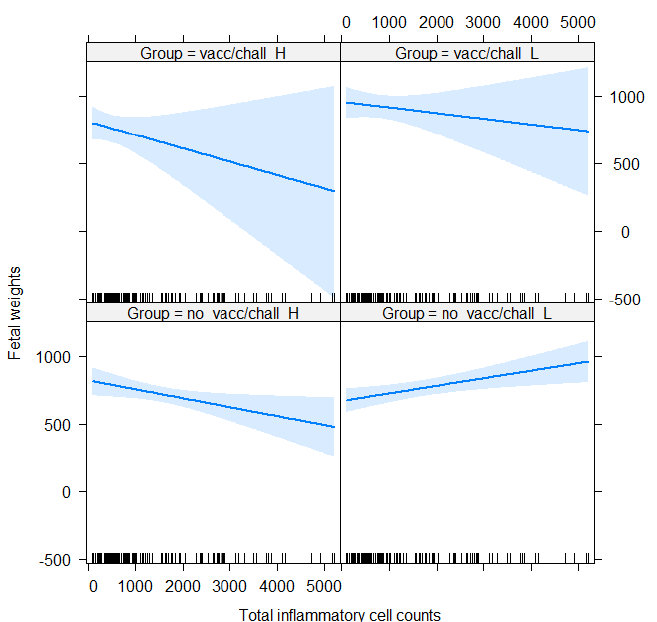
Figure 9. Correlations between fetal weights and total inflammatory cell counts. Based on the width of confidence bands, a significant correlation between fetal weight and total inflammatory cell count only appears in the unvaccinated groups.